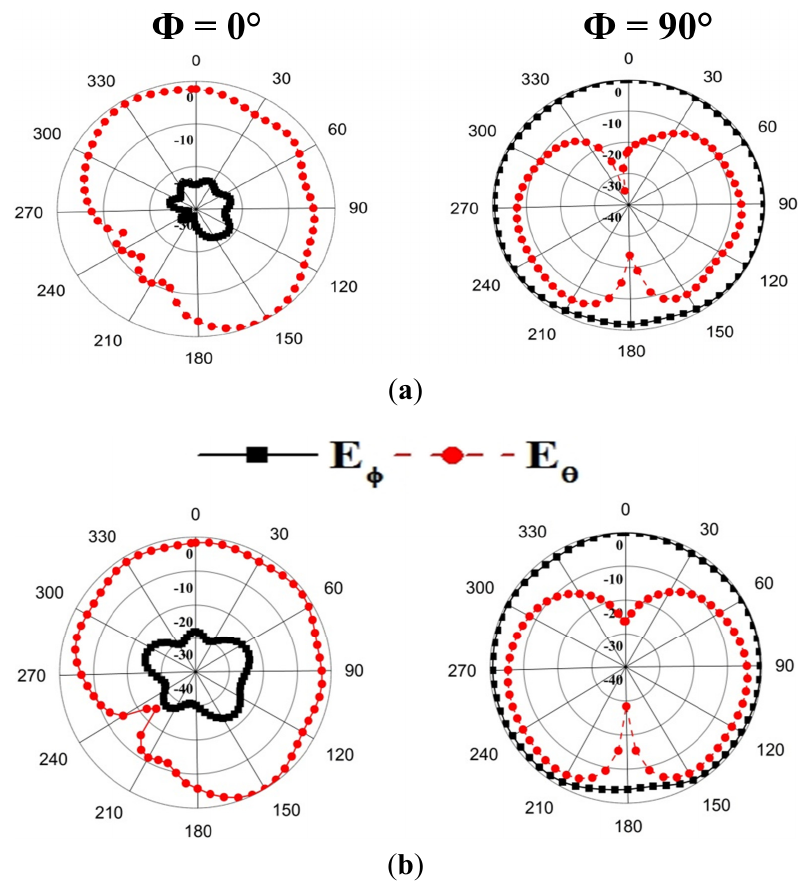
Figure 7. Measured radiation pattern of the proposed antenna. ( a ) 1.8 GHz; ( b ) 2.4